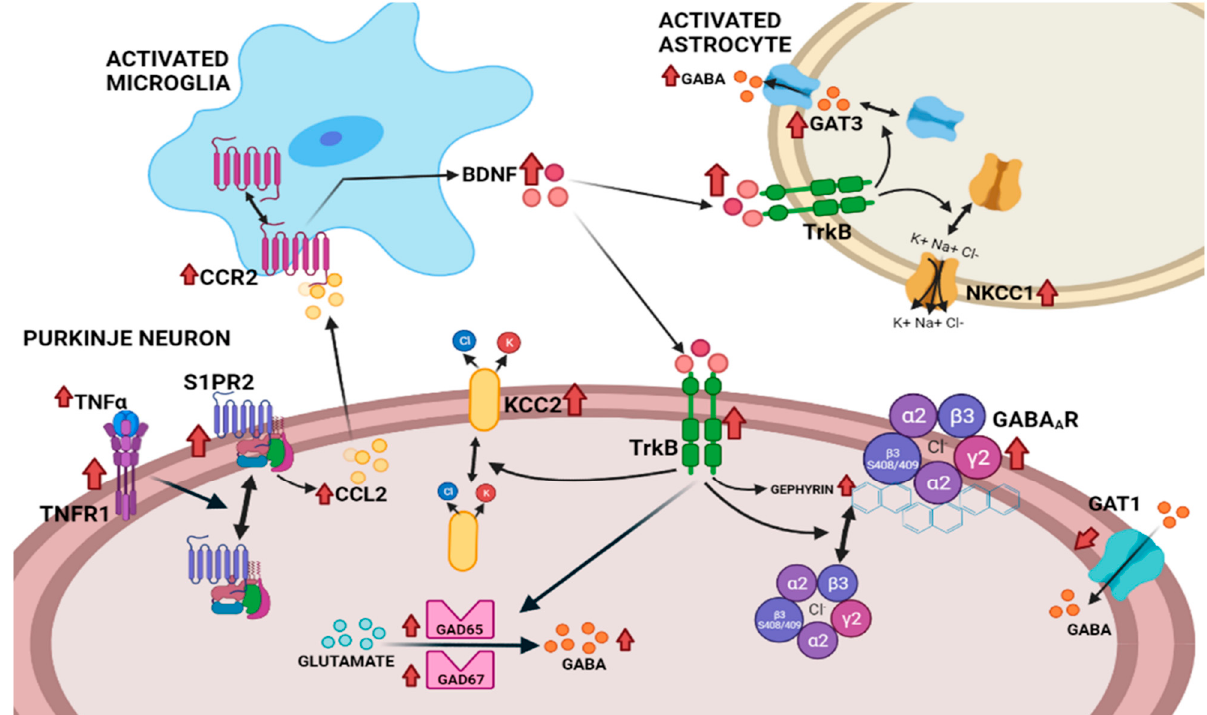
Figure 10. Proposed pathway by which the neuroinflammation-induced enhanced activation of the TNFR1–S1PR2–CCL2–CCR2–BDNF–TrkB pathway enhances GABAergic neurotransmission in the cerebellum of hyperammonemic rats. Hyperammonemia-induced neuroinflammation increases the levels of BDNF in microglia through the activation of the TNFR1–S1PR2–CCL2–CCR2 pathway. Increased levels of BDNF enhance the activation of TrkB in Purkinje neurons, leading to increased levels of GABA-synthesizing enzymes GAD65 and GAD67, and of GABA. Enhanced TrkB activation also increases the membrane expression of the γ 2, α 2, and β 3 subunits of GABAA receptors and of KCC2. Moreover, the enhanced activation of TrkB in activated astrocytes increases the membrane expression of GAT3 and of NKCC1, which also contributes to enhanced extracellular GABA. The increase in extracellular GABA and the membrane expression of GABAA receptors, and of KCC2 in Purkinje neurons results in enhanced GABAergic neurotransmission. All these changes in GABAergic neurotransmission are reversed by blocking TrkB or the TNFR1–SP1PR2–CCL2–CCR2–BDNF–TrkB pathway at any of its steps. The effects of hyperammonemia are indicated with red arrows ( ↑ ).